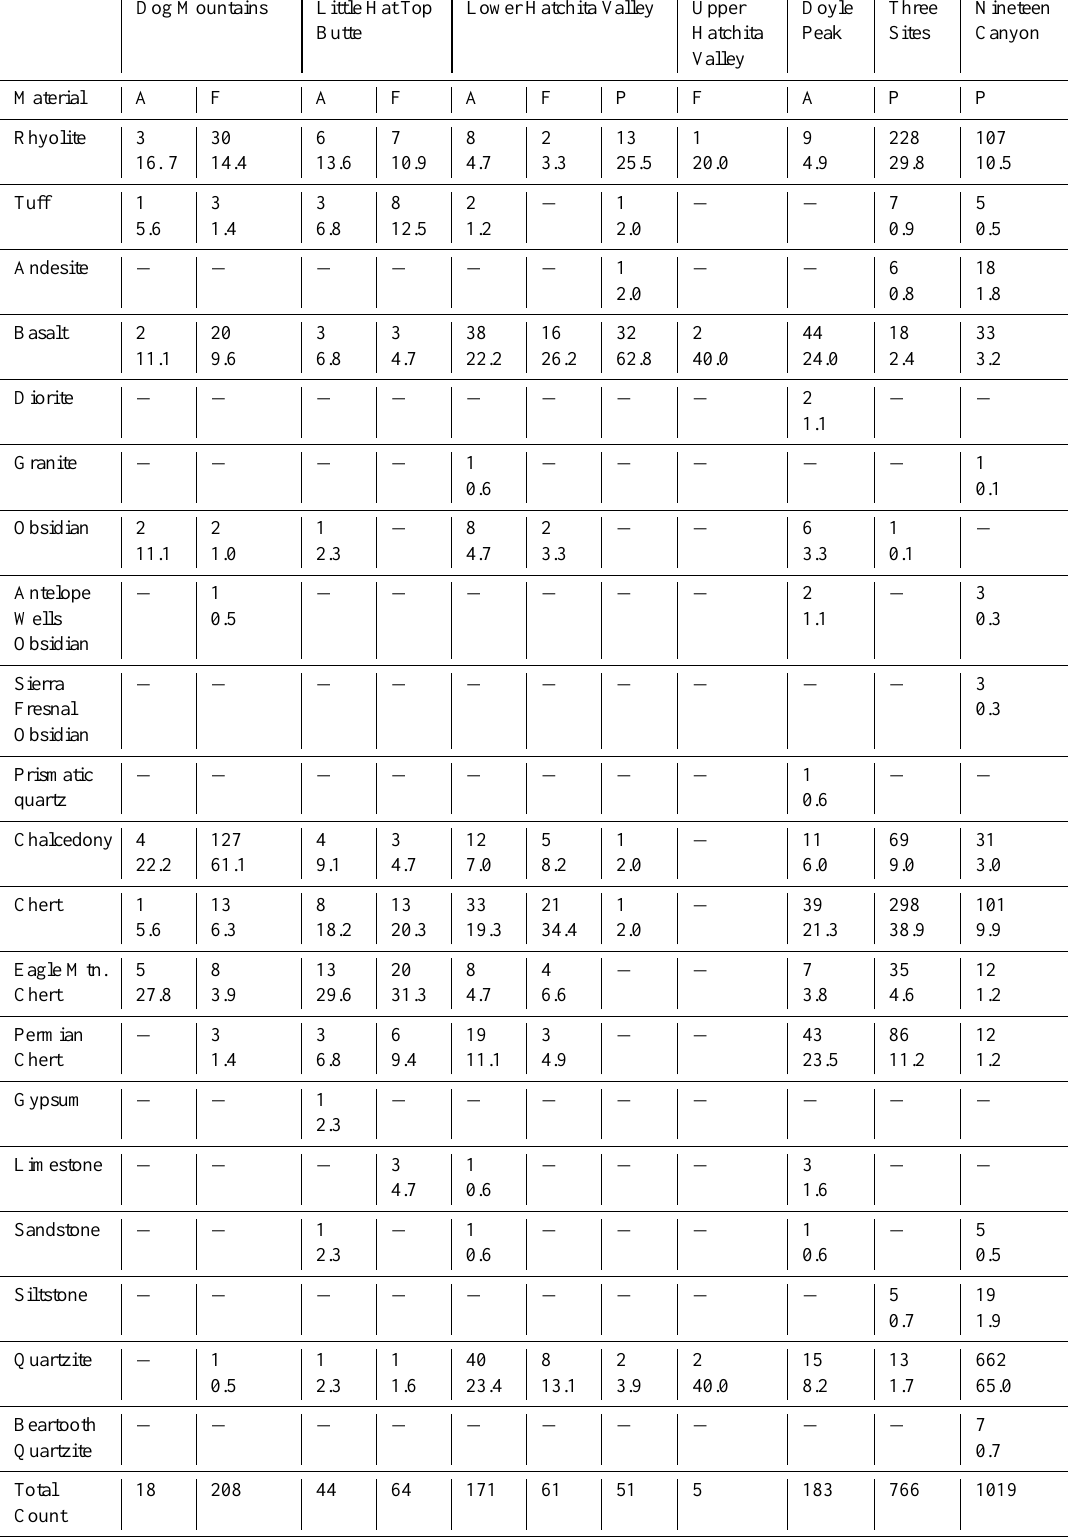
Doyle Three Nineteen Hatchita Peak Sites Canyon Valley